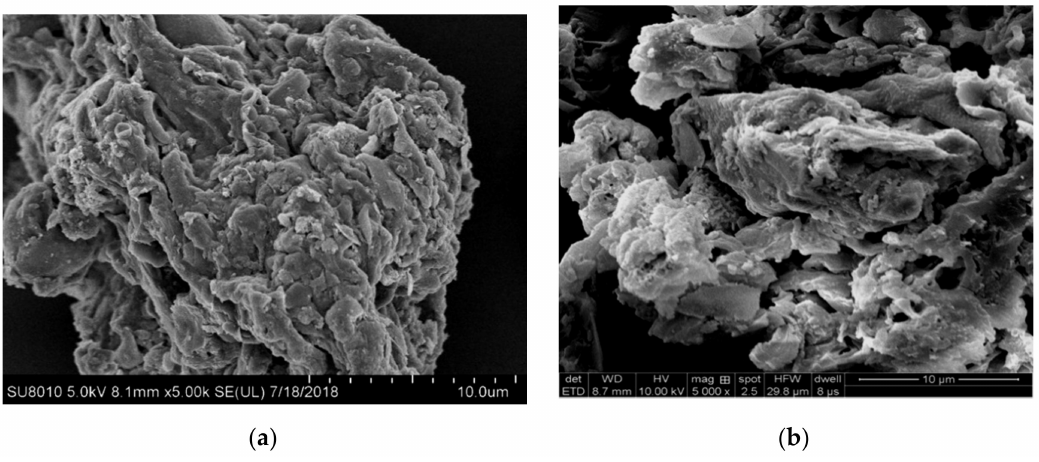
Figure 2. SEM images of MSB300 ( a ) and MSB500 ( b